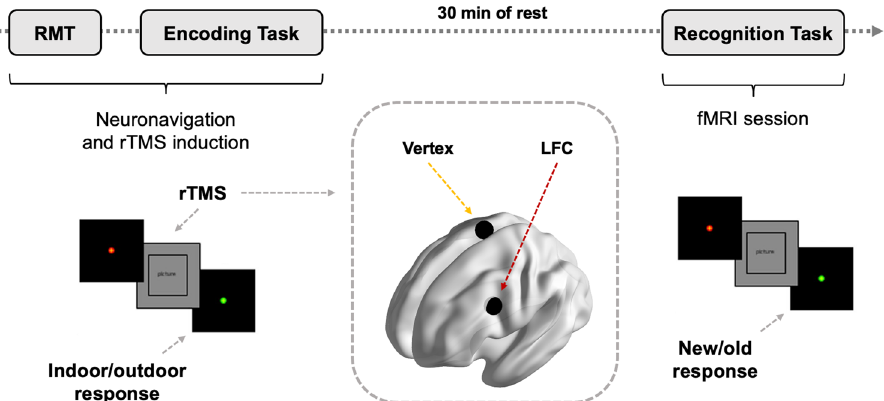
Figure 1. Study design overview. Participants underwent an encoding visual memory task while receiving rTMS over the LFC (MNI coordinates: X = − 42; Y = 10; Z = 30, according to Martin-Trias and colleagues 34 ; pointed with a red arrow) or the vertex area (MNI coordinates: X = 4; Y = − 16; Z = 70, from Cz location according to Rojas et al. 68 , created for visual purposes, pointed with a yellow arrow). After a 30 min rest, participants completed the recognition of the visual memory task (i.e., discrimination between seen/not seen items in encoding phase) within the MRI scanner. RMT, resting motor threshold; rTMS, repetitive transcranial magnetic stimulation; LFC, left frontal cortex; fMRI, functional magnetic resonance